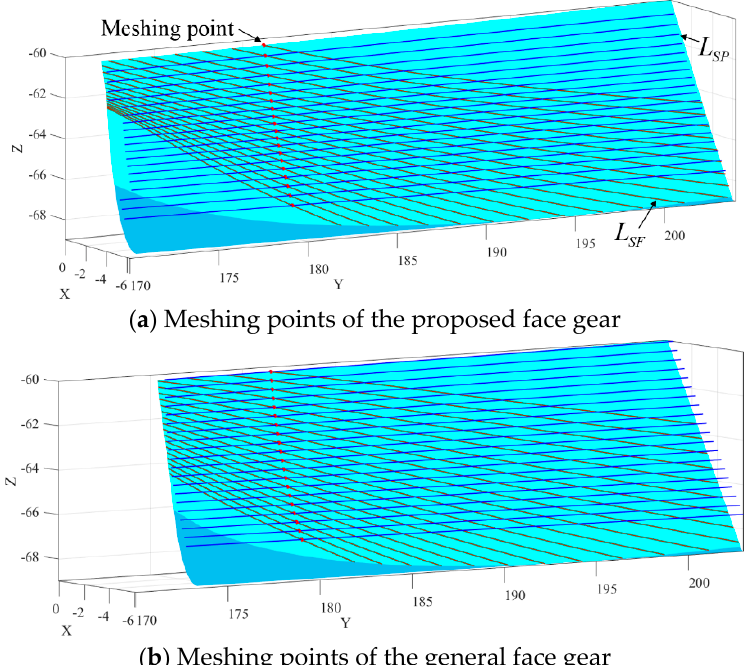
Figure 7. Meshing points of two face gears.